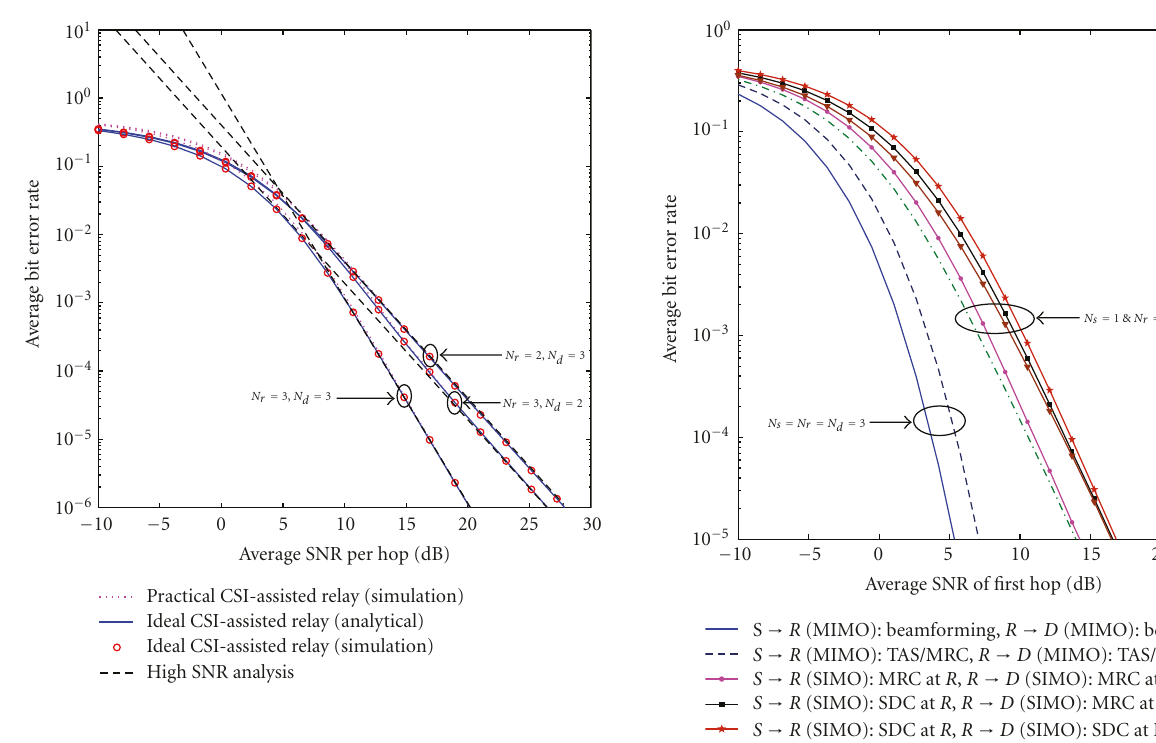
Figure 11: Average BER of several dual-hop MIMO AF relay system models over arbitrary correlated Rayleigh fading channels. γ θ r = θ d = π/ 4, l r = l d = 0 . 6, and σ 2